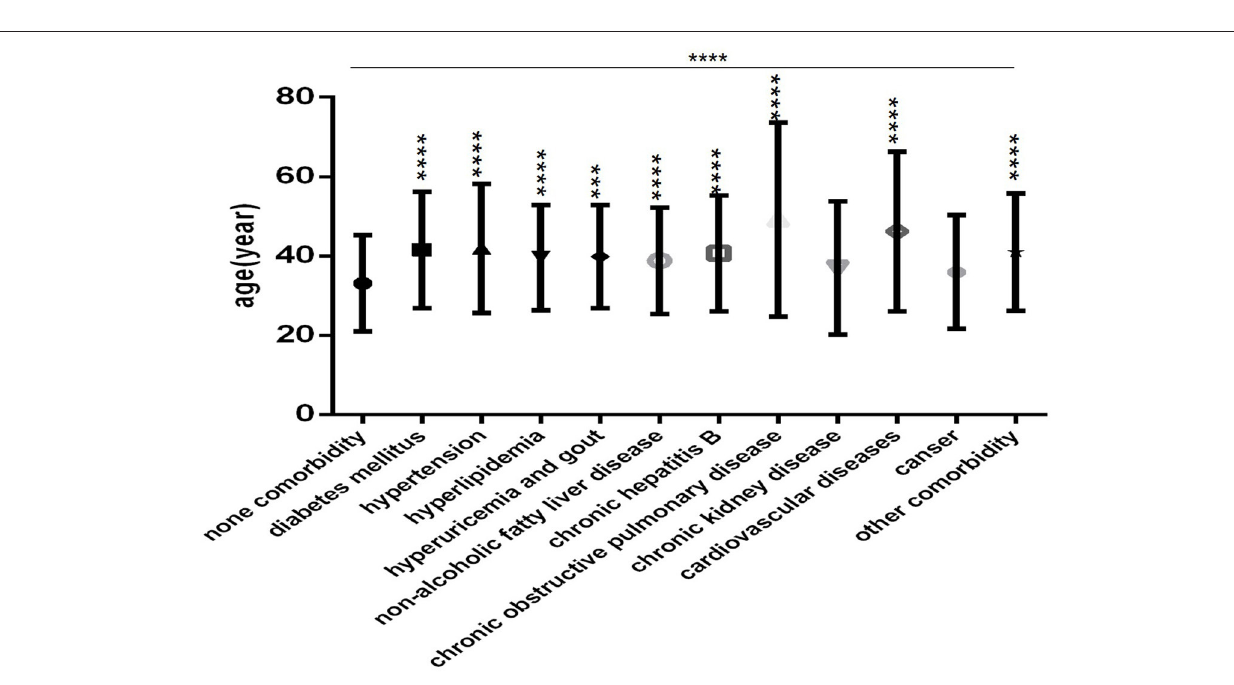
FIGURE 3 | Comparison of age among the no comorbidity group and each comorbidity group ( n = 718; 0, 1, 2, 3 or more comorbidities groups, n = 253, 193, 127, and 145, respectively). COVID-19, coronavirus disease 2019. Unpaired one-way ANOVA was used for intergroup comparisons ( P < 0.0001). Unpaired t -tests were used for comparisons with the control group, *** P < 0.001, **** P <